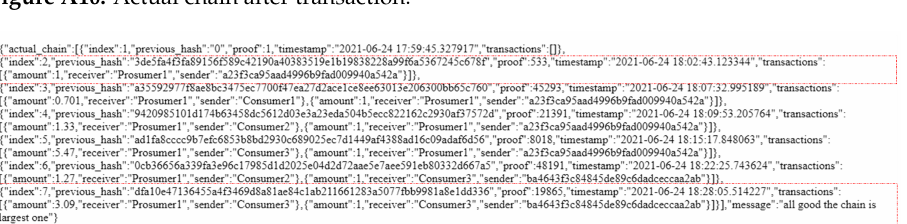
Figure A10. Actual chain after transaction.